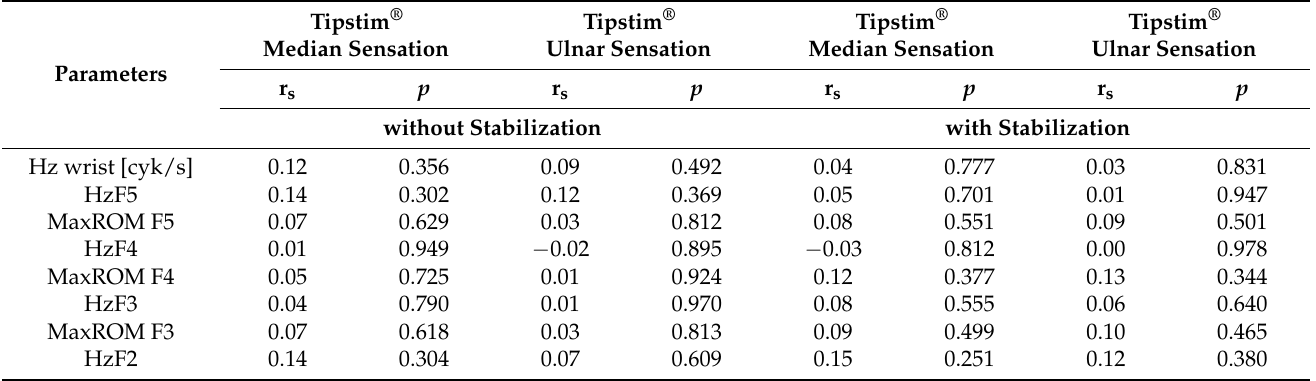
Table 8. Spearman correlation coefficients (rs) for the relationship between the tipstim ® parameters and the motor coordination